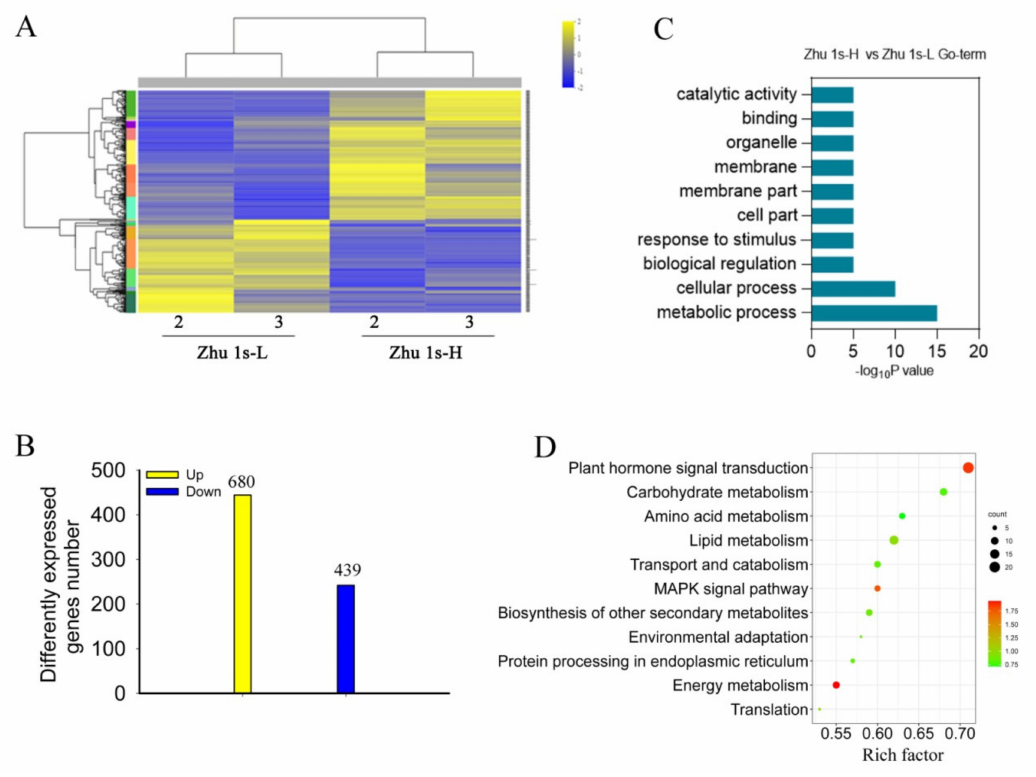
Figure 2. Transcriptome analysis on the anthers of Zhu 1S under low (Zhu 1S − L) and high (Zhu 1S − H) temperature. ( A ) Hierarchical cluster analysis of gene expression in Zhu 1S − H and Zhu 1S − L. The yellow and blue colors represent increased and decreased transcript level, respectively. ( B ) The up- and down-regulated gene numbers in Zhu 1s − H relative to Zhu 1s − L. ( C ) GO enrichment analysis for differential expression in Zhu 1S − H compared to Zhu 1S − L. ( D ) KEGG pathway analysis for differential expression in Zhu 1S − H compared to Zhu 1S −